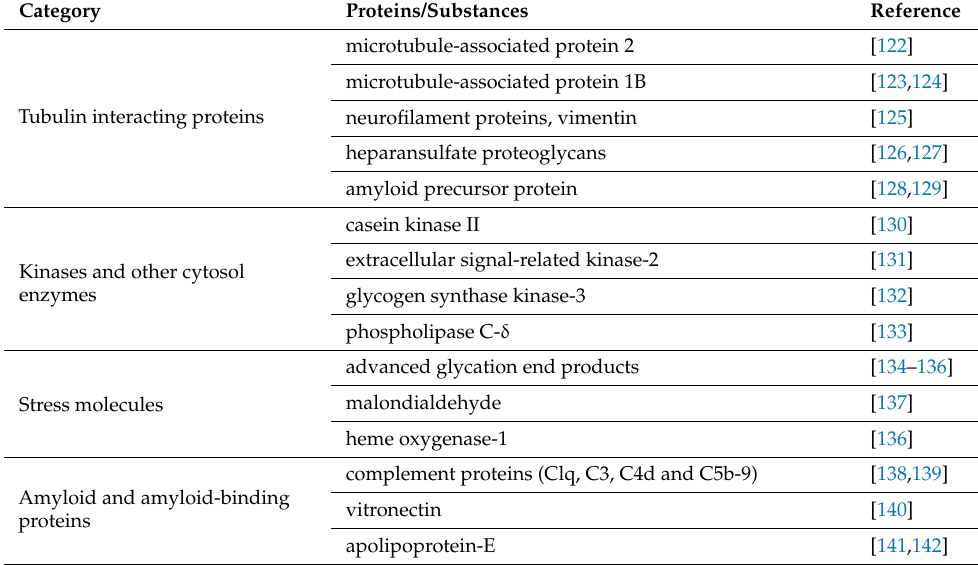
Table 1. Overview of proteins and substances found mounted in paired helical filaments and neurofibrillary